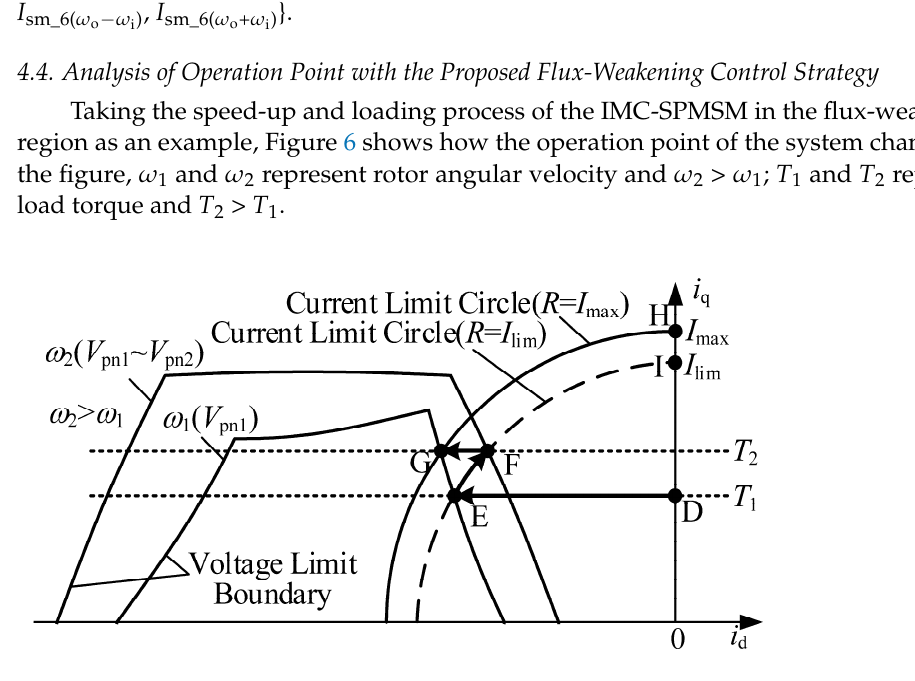
Figure 6. Trajectory of operation point with the proposed strategy in the flux-weakening region. Assume the current operation point is located at Point E, i.e., speed of SPMSM is ω 1 and load torque is T 1 . In the area of speed below ω 1 , ∆ v q ≥ 0 and I ref ≤ I lim , and only PART_1 works. If speed and torque increase synchronously to ω 2 and T 2 , respectively, the operation point moves to Point F along the arc of EF. During the process, ∆ v q ≥ 0, I ref > I lim , the actual current of SPMSM reaches I lim , and PART_2 works. As a result, when the endpoint of the stator current vector exceeds the current limit circle ( R = I lim , R is the radius of the limit circle), the rectifier stage modulation depth controller increases the output voltage of the IMC by increasing α , which means the voltage boundary enlarged and the endpoint of the current vector is pulled back to the current limit circle ( R = I lim ). PART_2 reaches saturation if α reaches the maximum value of π /6 at Point F. Then, the operation point moves to Point G along FG with speed increasing and the load torque unchanged by keeping the rectifier stage only working in the modulation mode of CASE 2.